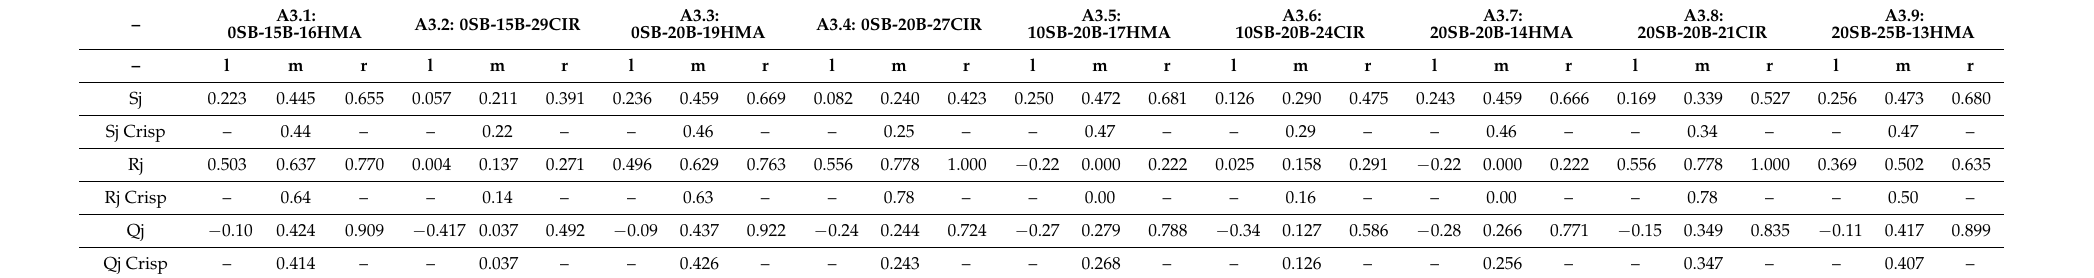
Table 6. Ranking of pavement scenarios (No. 10 not included due to space limitations) using